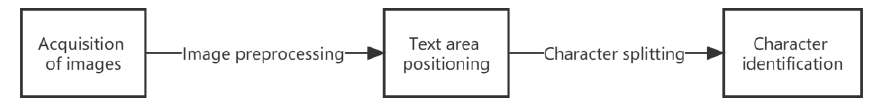
Figure 1. Traditional method for image text detection and recognition.